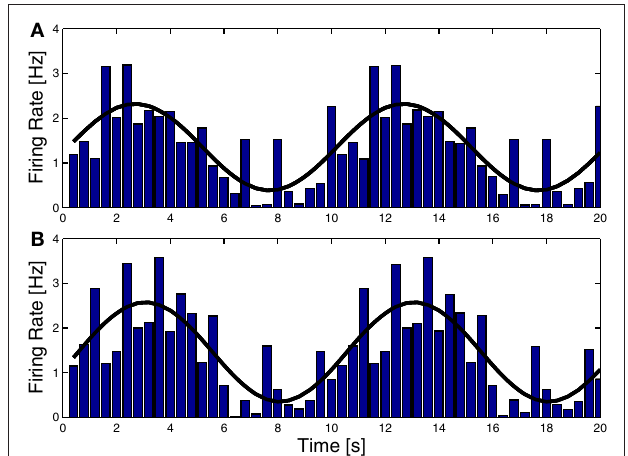
FIGURE 7 | Complex spike (CS) Modulation as a result of sinusoidal optokinetic stimulation. In (A) the stimulus was an oscillating pattern. In (B) the same pattern moved transparently over a static background. The behavior of the animal varied with the relative luminances of the moving and the static pattern. The frequency of the fi tted sine wave equals the frequency of the stimulus (0.1 Hz). Note that the modulation in (A) and (B) is virtually identical, as are the CEM made by the animal (gain 0.60 and 0.58, respectively). Consequently the predicted slip (caused by the eye movement over the static pattern) is not refl ected in the CS (Frens et al.,